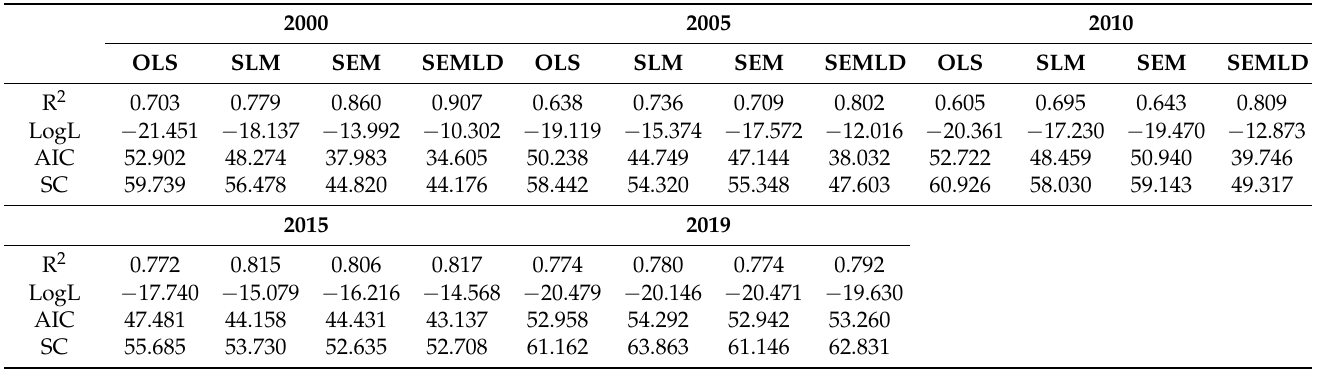
Table 4. Spatial regression results for per CO 2 emissions in China (five-time